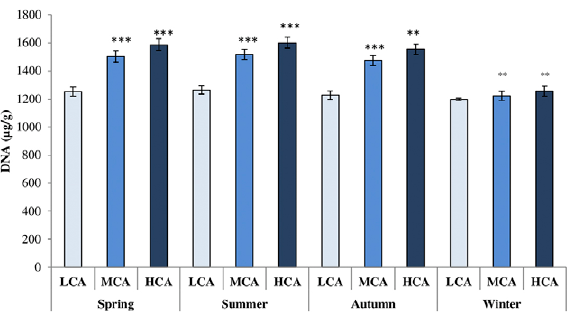
Fig. 5. – Seasonal deterioration among seasons of the DNA structure isolated from R. decussatus collected from Tunisian coastal lagoons: Ghar el Melh (LCA), the North Lake (MCA) and the South Lake (HCA). Results are presented as mean±SD. Significant differences